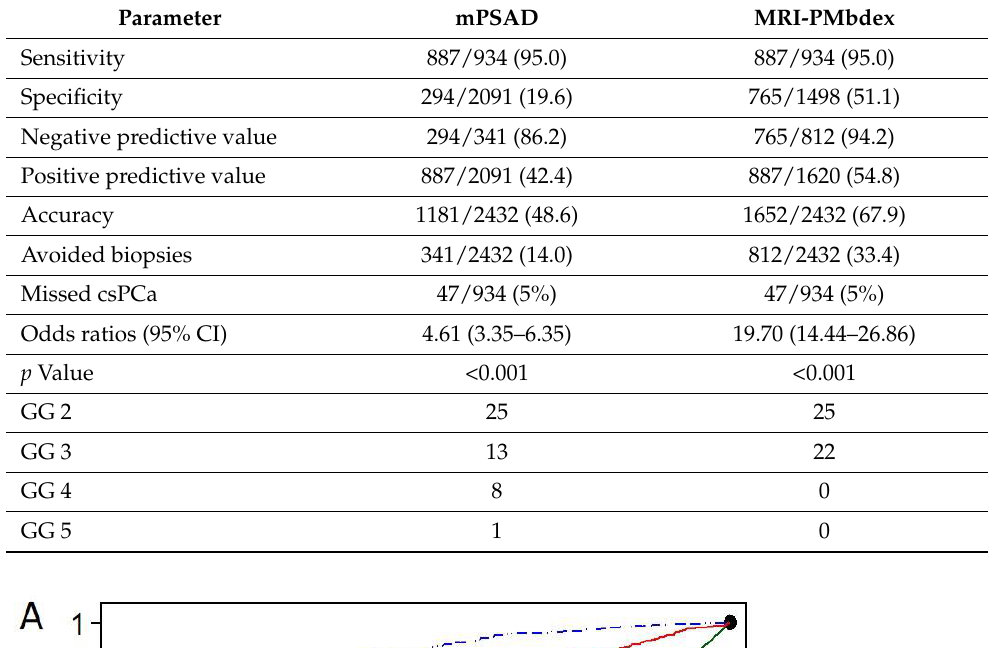
Table 3. Performance of mPSAD and MRI-PMbdex, with respective thresholds of 0.628 ng/mL 2 and 13.5%, in the entire study population and grade groups of detected tumours.